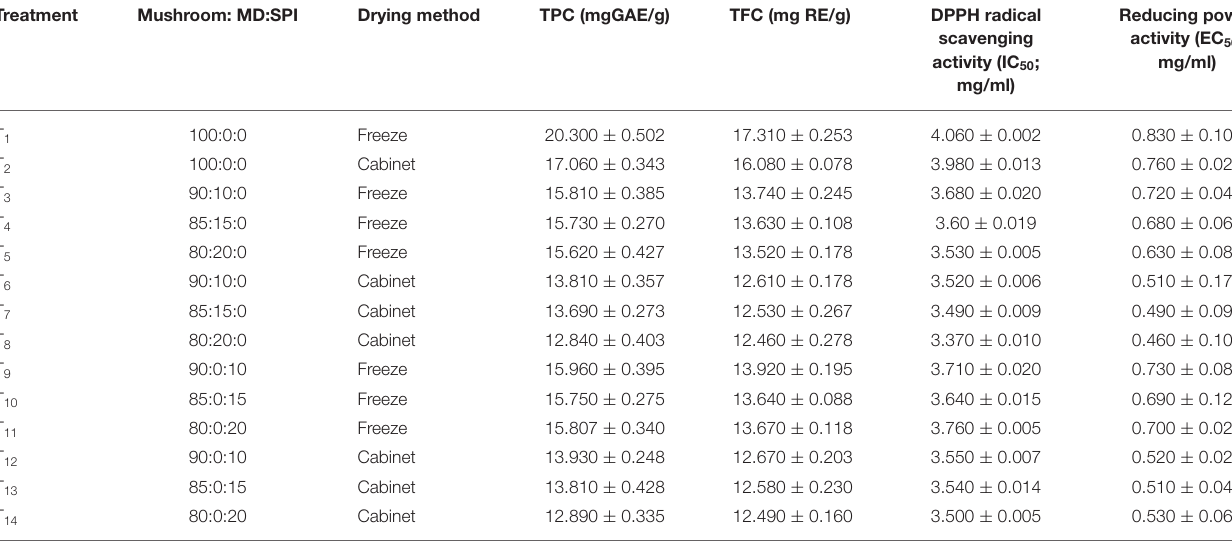
TABLE 5 | Bioactive properties of BMP.